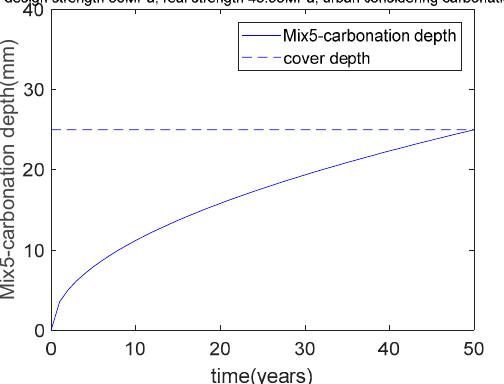
Figure 9. Carbonation depth of Mix5 concrete in an urban region considering carbonation.